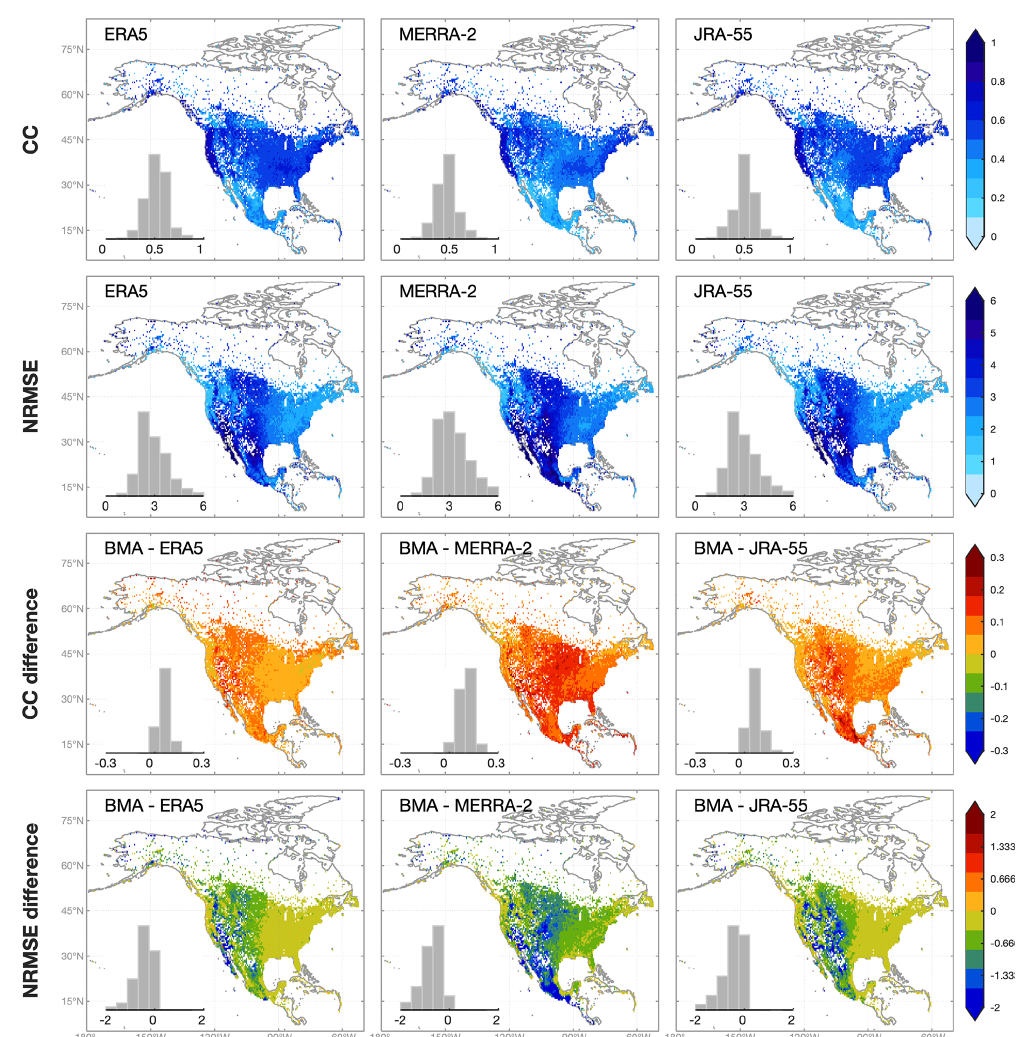
Figure 3. The spatial distributions and histograms of CC (the first row) and NRMSE (the second row) based on raw reanalysis precipitation estimates (ERA5, MERRA-2, and JRA-55). The improvement of BMA-merged estimates against raw reanalysis estimates is shown in the third and fourth rows. The maps are at the 0.5 ◦ resolution, and the value of each 0.5 ◦ grid point is the median metric of all stations located within the